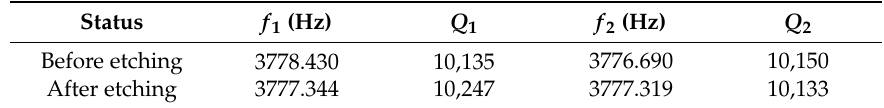
Table 3. Quality factors of H02 before and after chemical etching along the higher-frequency axis and the lower-frequency axis.